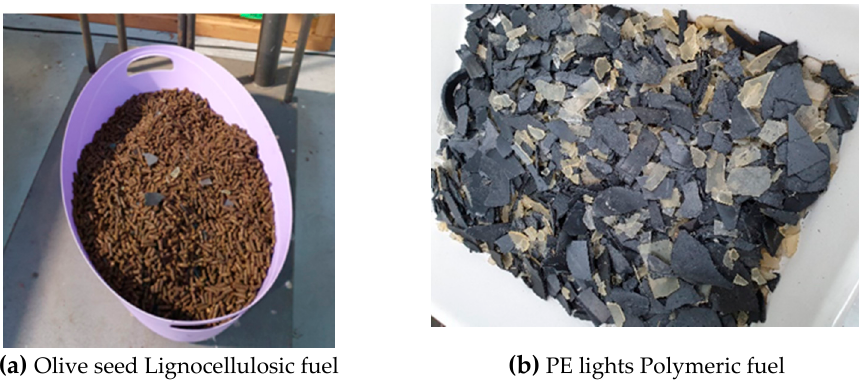
Figure 3. Raw materials used for joint gasification in the reactor. ( a ) Olive biomass residues (pellet). ( b ) Plastic waste. (Source: self-made).